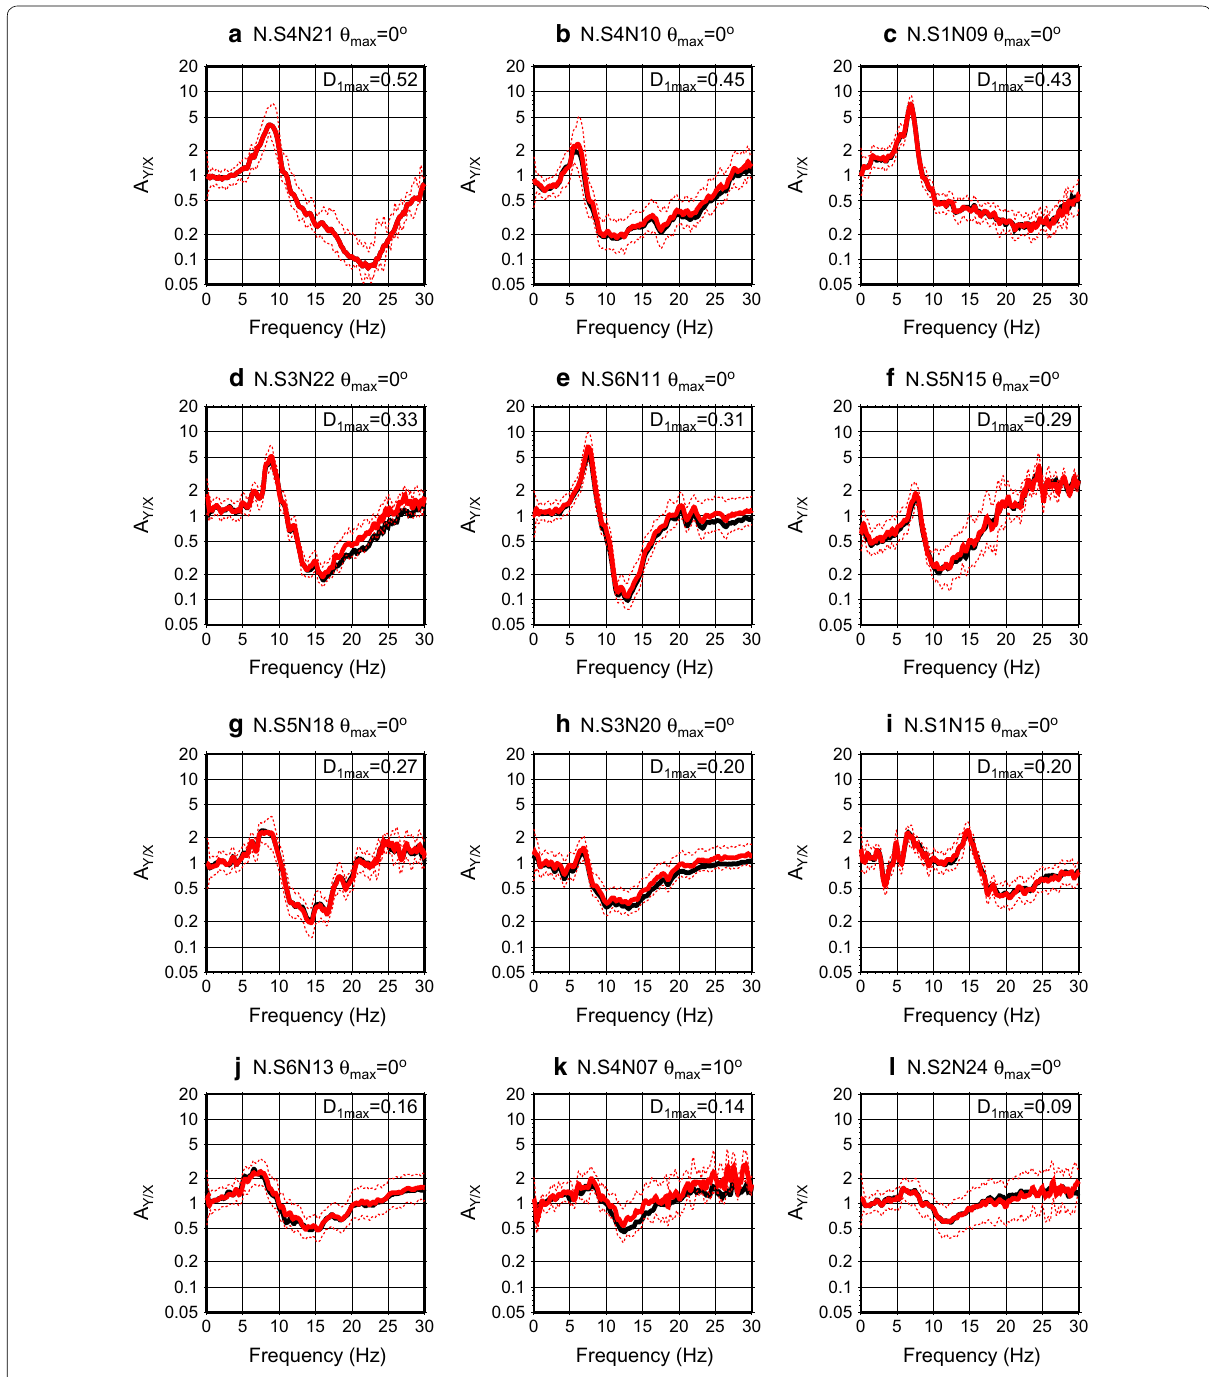
Fig. 15 Same figure as Fig. 7 except that only the earthquakes satisfying the 45 ratio. Black curves are the result for the case of using all the available earthquakes (same as Fig.